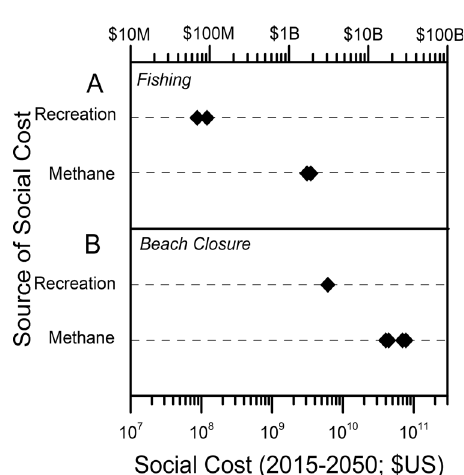
Fig. 1 Comparison of the recreational vs. climate implications of eutrophication. A The welfare gain, 2015 – 2050, from a 40% reduction in phosphorus (P) loading to western Lake Erie reducing the frequency and extent of harmful algal blooms (HABs). The range of economic impact on recreational angling was estimated from the annual welfare gain 17 assuming constant annual bene fi ts and a 3% yr − 1 discount rate. The welfare gain from this same total P loading to Lake Erie was estimated from the corresponding reduction in CH 4 emissions (and CO 2 -equivalent emissions) through 2050, using estimates and methods reported in Table 2. B The welfare cost of seasonal Lake Erie HABs suf fi cient to close beaches, of daily recreational losses from the closure of all 67 Lake Erie beaches in annually, 2015 – 2050, using a 3% yr − 1 discount rate. Methane cost